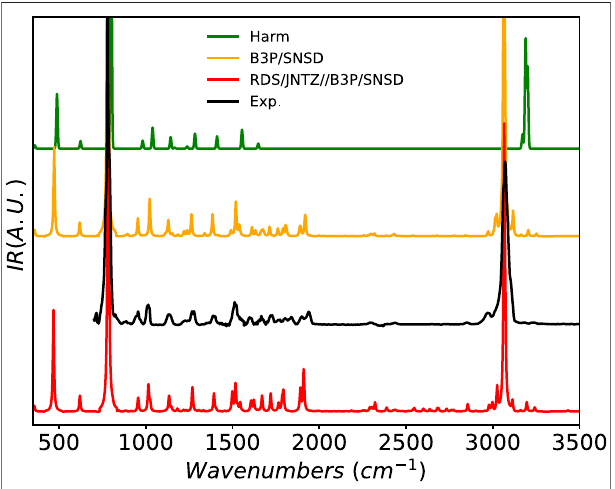
FIGURE 8 | Infrared spectrum of fl uorobenzene at the B3PW91/SNSD ( B3P/SNSD ), revDSD-PBEP86-D3(BJ)/jun-cc-pVTZ ( RDS/JNTZ ) and revDSD-PBEP86-D3(BJ)/jun-cc-pVTZ//B3PW91/SNSD levels using the GVPT2 scheme, compared to experiment taken from (NIST Mass Spec Data Center and Stein, 2015). Theoretical line-shapes were broadened by mean of Lorentzian distribution functions with half-widths at half-maximum of 4 cm − 1 .